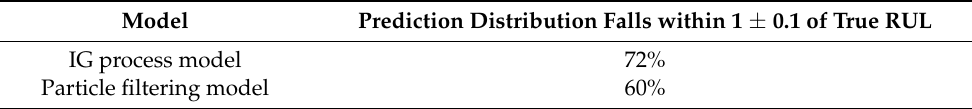
Table 3. Distributions of predicted RUL based on deviation